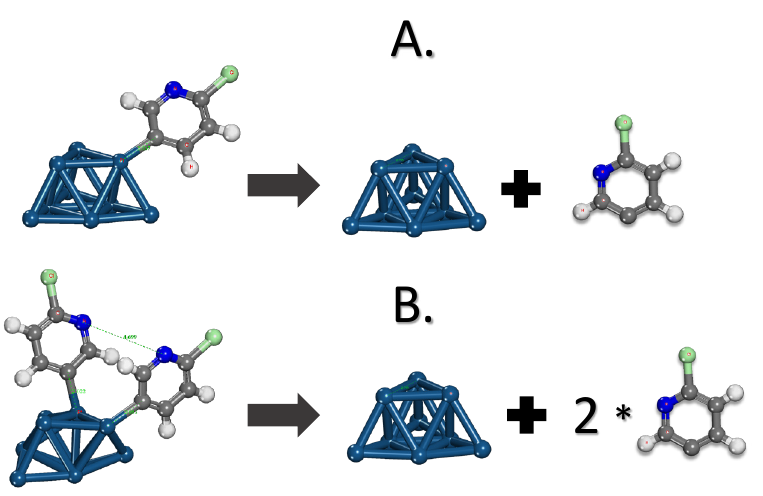
Figure 4: Bond dissociation energies (calculated by DFT based on GGA/PBE and double-numeric quality with polarization function) for a platinum claster of 9 atoms grafted with: A. one and B. two grafted pyridine moieties.